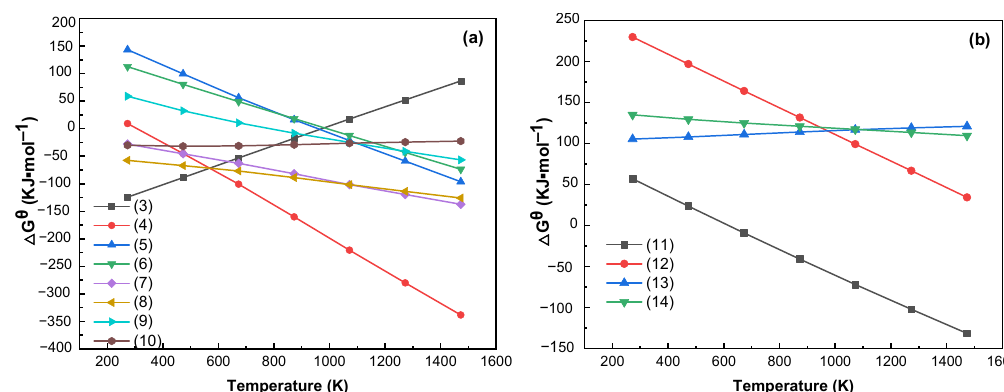
Figure 2. Correlation of standard Gibbs free energy ( ∆ G θ ) with temperature for Reactions ( a ) Reactions (3)–(10); ( b ) Reactions (11)–(14).